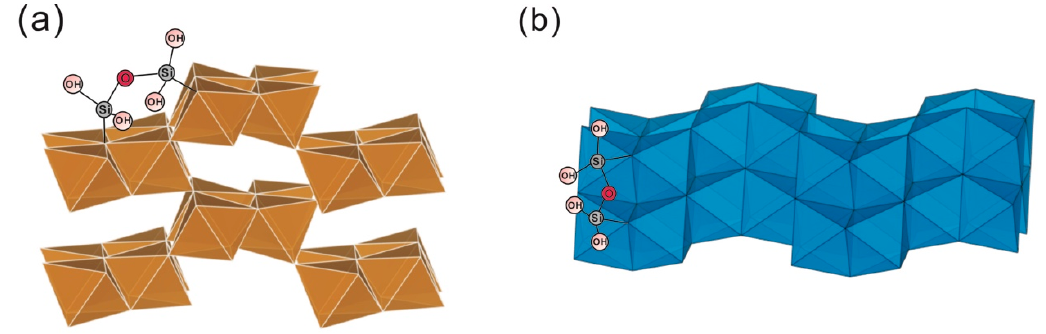
Figure 5. Schematic illustration of bonding structures of polymerized silicic acid with goethite ( a ) and ferrihydrite ( b ) minerals. Octahedra represent the atomic shells in iron oxy-hydroxide minerals.